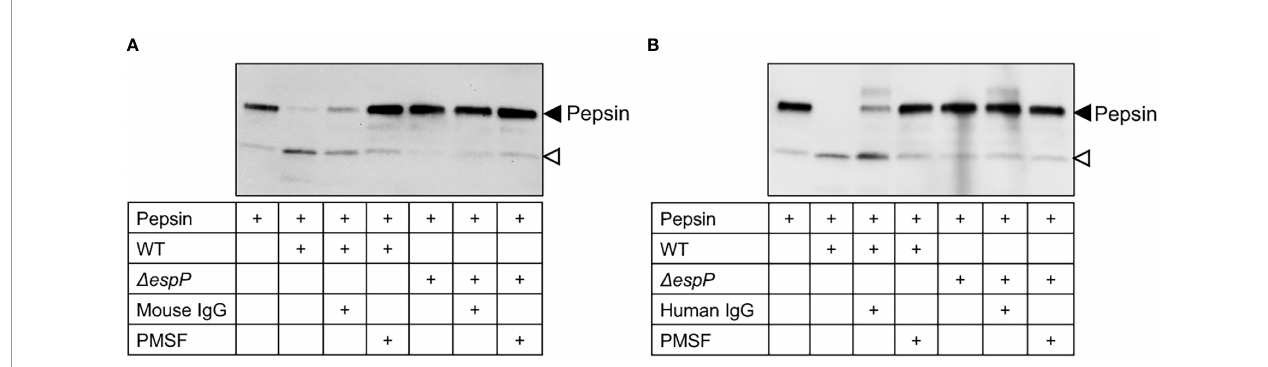
FIGURE 7 | Mouse and human IgG inhibit EspP-mediated pepsin cleavage. Pepsin incubated alone or with wild-type or D espP E. coli O157:H7 culture fi ltrates was loaded onto a membrane for detection of pepsin cleavage. Supernatant pre-incubated with mouse IgG (A) or human IgG (B) partially inhibited EspP activity. Full- length pepsin was detected at approximately 40kDa, marked with a black arrowhead, and the cleavage product was detected at approximately 20kDa marked with an open arrowhead. WT, culture fi ltrate from the wild-type E. coli O157:H7 strain; D espP , culture fi ltrate from the EspP mutant; IgG, immunoglobulin G; PMSF, phenylmethylsulfonyl